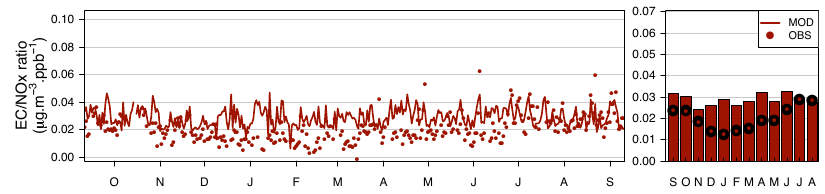
Figure 10. Local EC / NO x ratio time series (left) and monthly averages (right) for model (line and bar) and observations (points).